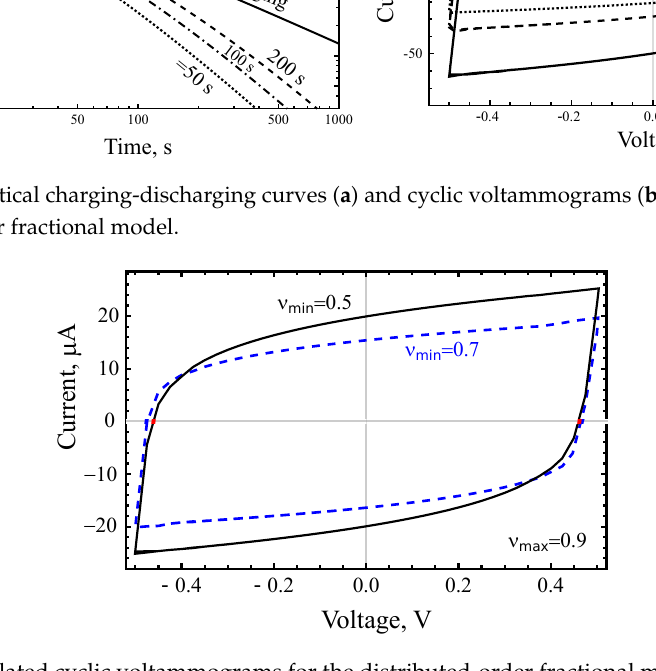
Figure 10. Calculated cyclic voltammograms for the distributed-order fractional model of PMSC for two values of ν min .